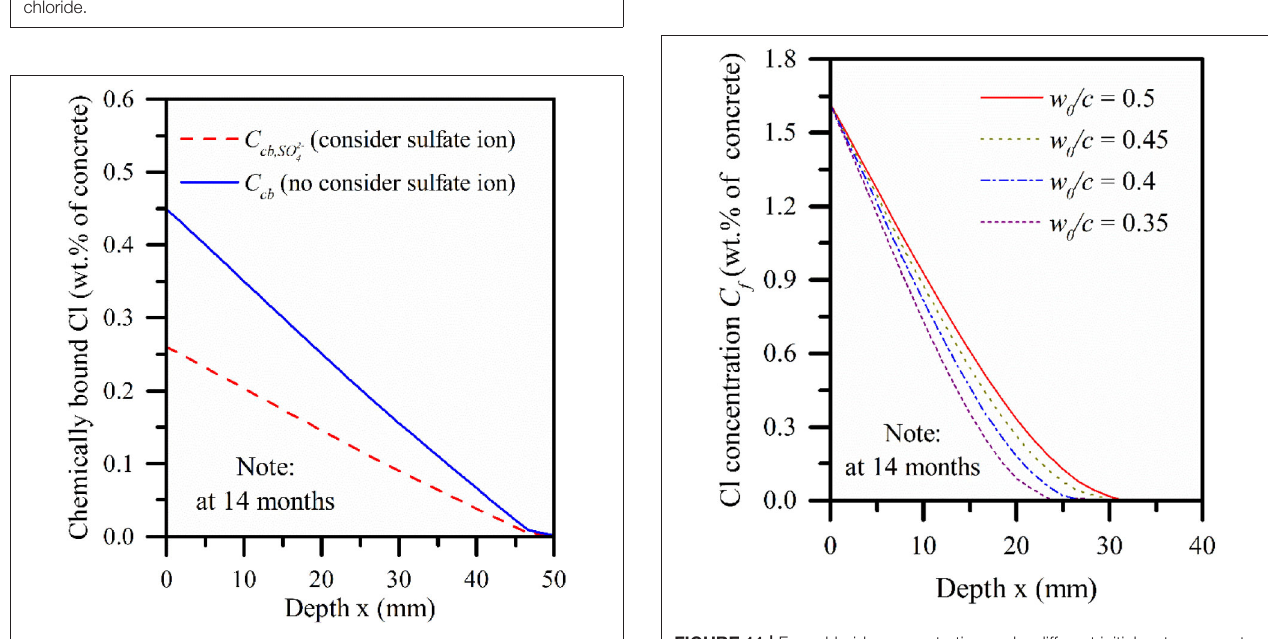
FIGURE 9 | Chemical binding curve of chloride ion: red solid line (sulfate ion is considered), blue solid line (sulfate ion is not considered).